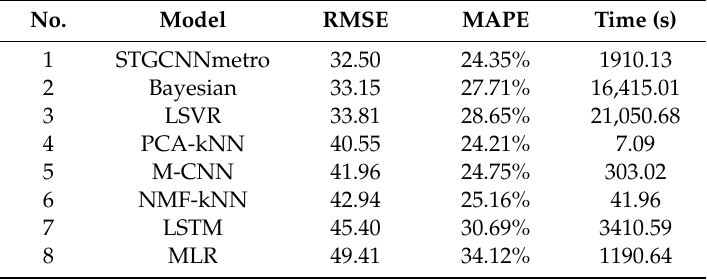
Table 2. Root-mean-square error (RMSE) and mean absolute percentage error (MAPE) values for di ff erent